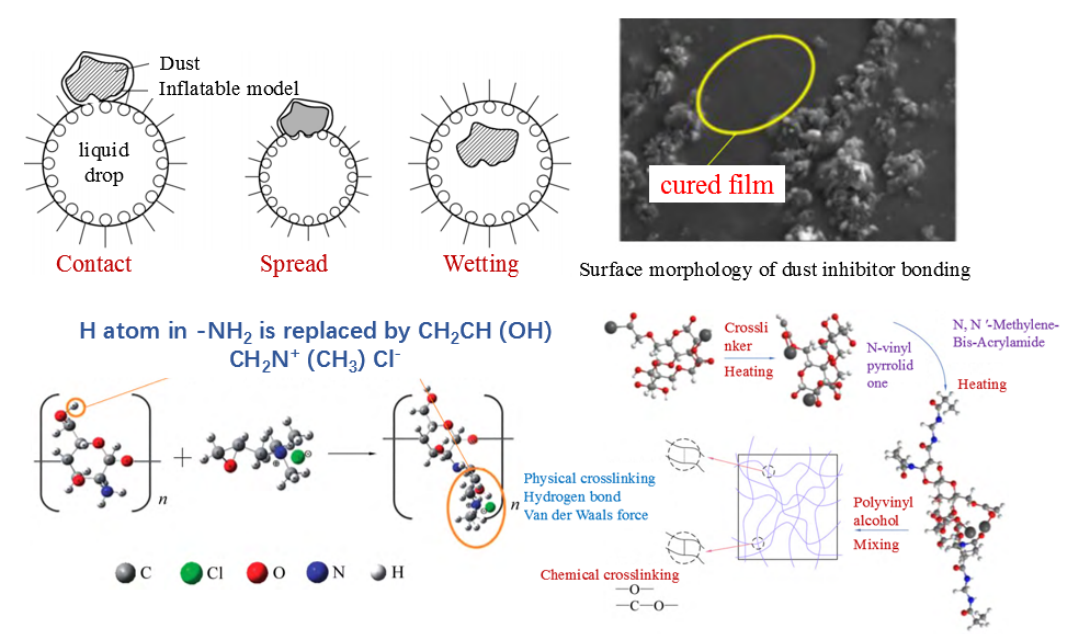
Figure 10. Dust suppression mechanism of dust inhibitor [65–67].